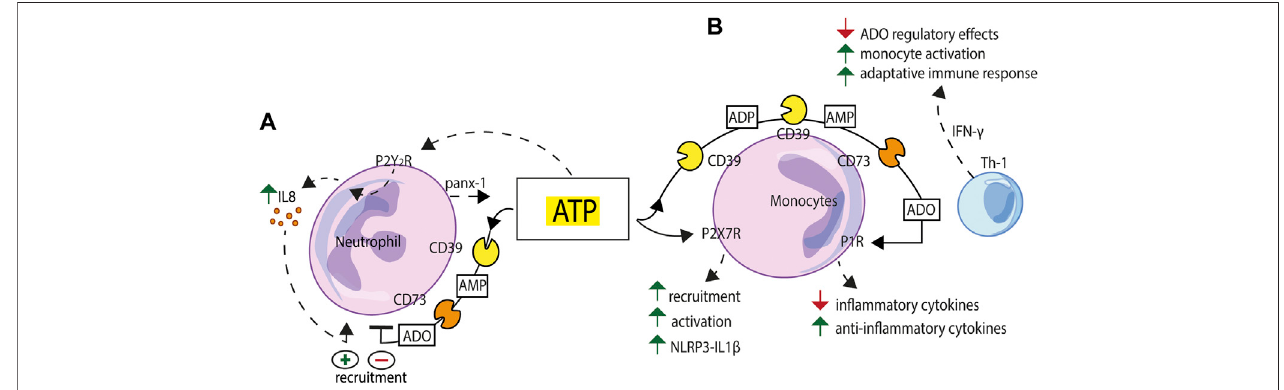
FIGURE 3 | Schematic exempli fi cation of purinergic receptor/ectonucleotidase cooperation in the activation/inhibition of the innate immune response. (A) ATP released via pannexin-1 (panx-1) from human neutrophils exposed to in fl ammatory stimuli triggers IL-8 production acting at the P2Y2R. NTPDase1/CD39 and NT5E/CD73 sequentially degrade extracellular ATP and limit neutrophil recruitment. (B) Extracellular nucleotides, fi rstly ATP, acting at the P2X7R, promote monocyte recruitment, modulate phagocytosis and support NLRP3 in fl ammasome-mediated IL-1 β release. NTPDase1/CD39 and NT5E/CD73, expressed to high level on the macrophage plasma membrane, generate adenosine (ADO) and support a feed-back regulatory mechanism. Adenosine-mediated P1R stimulation generates an anti-in fl ammatoryenvironmentcharacterizedbydown-modulationofin fl ammatorycytokinesreleaseandenhanced secretionofanti-in fl ammatorycytokinesandgrowth factors.Thisbalancecanbetiltedtowardsanactivatedstate,e.g.,tosupportamorevigorousadaptiveimmuneresponse,byIFN- γ ,astimulusthatmakesmacrophages less sensitive to adenosine